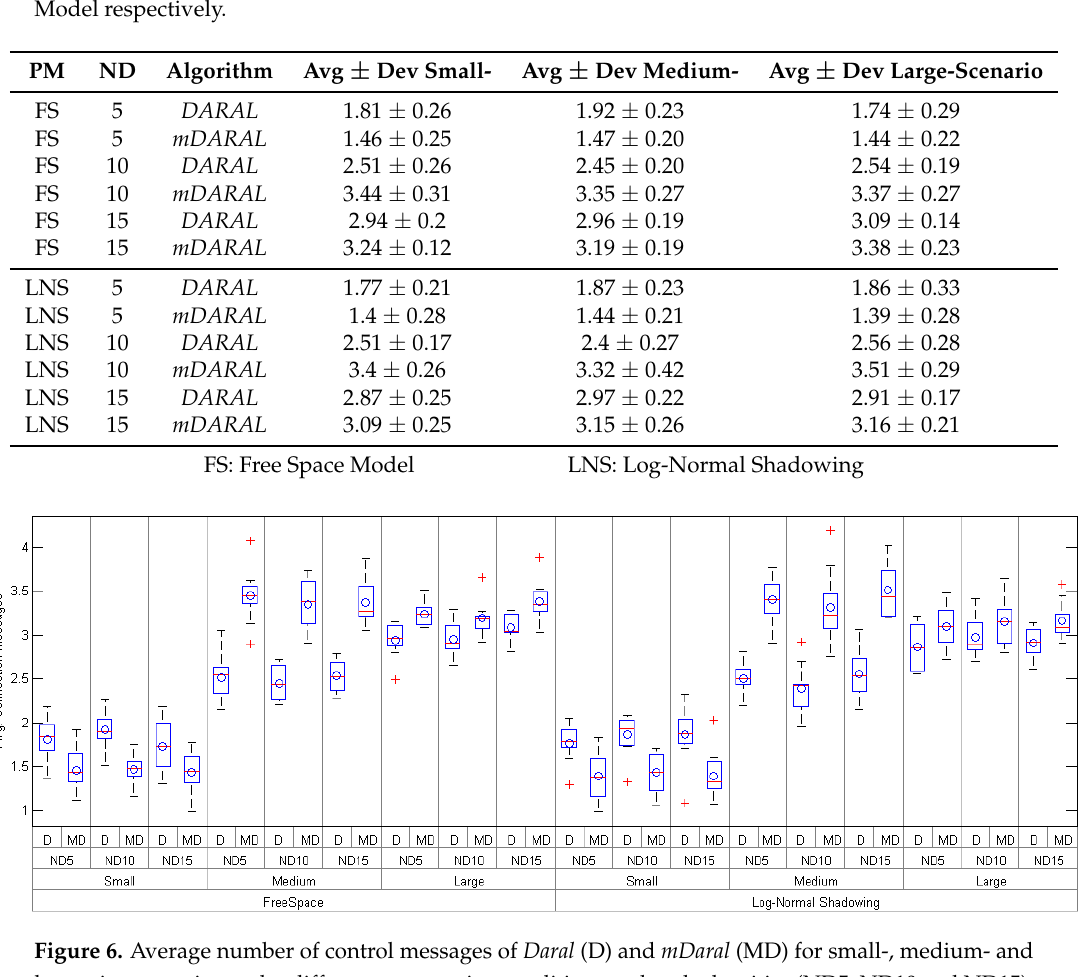
Table 3. Average number of control messages for small-, medium- and large-size scenarios under different propagation conditions. ND and PM stand for Node Density and Propagation Model respectively.